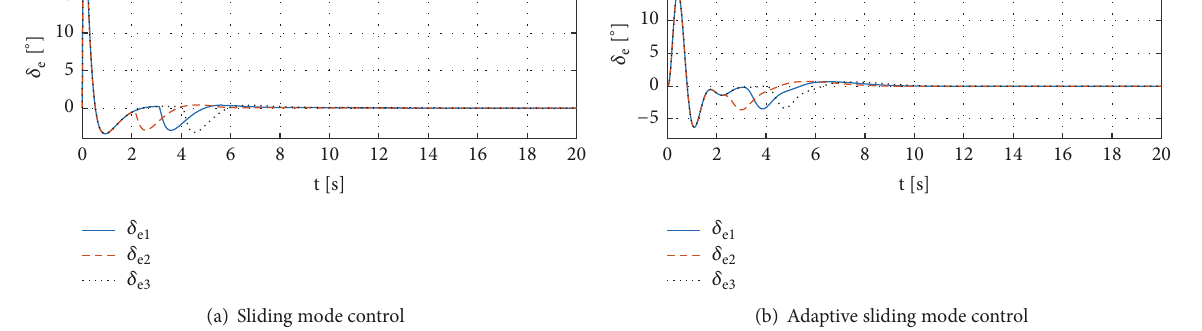
Figure 6: The rudder input of each AUV.